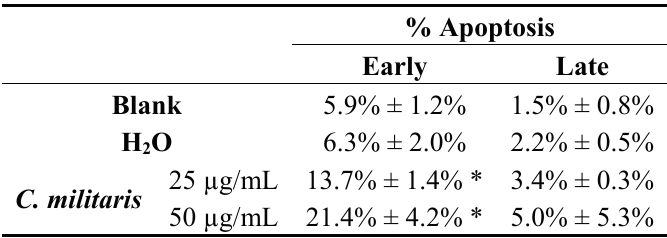
Table 1. Apoptosis levels in NCI-H460 cells treated with C. militaris fruiting body methanolic